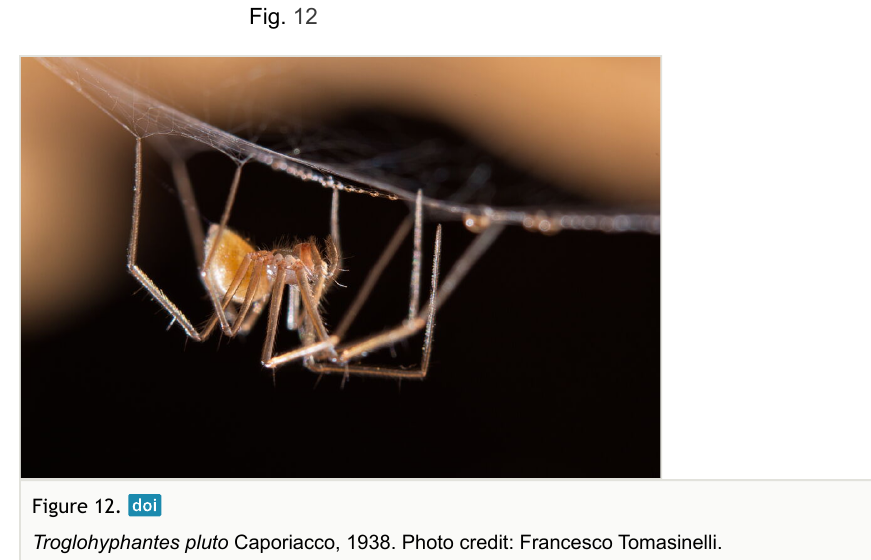
Map of records (Google Earth):